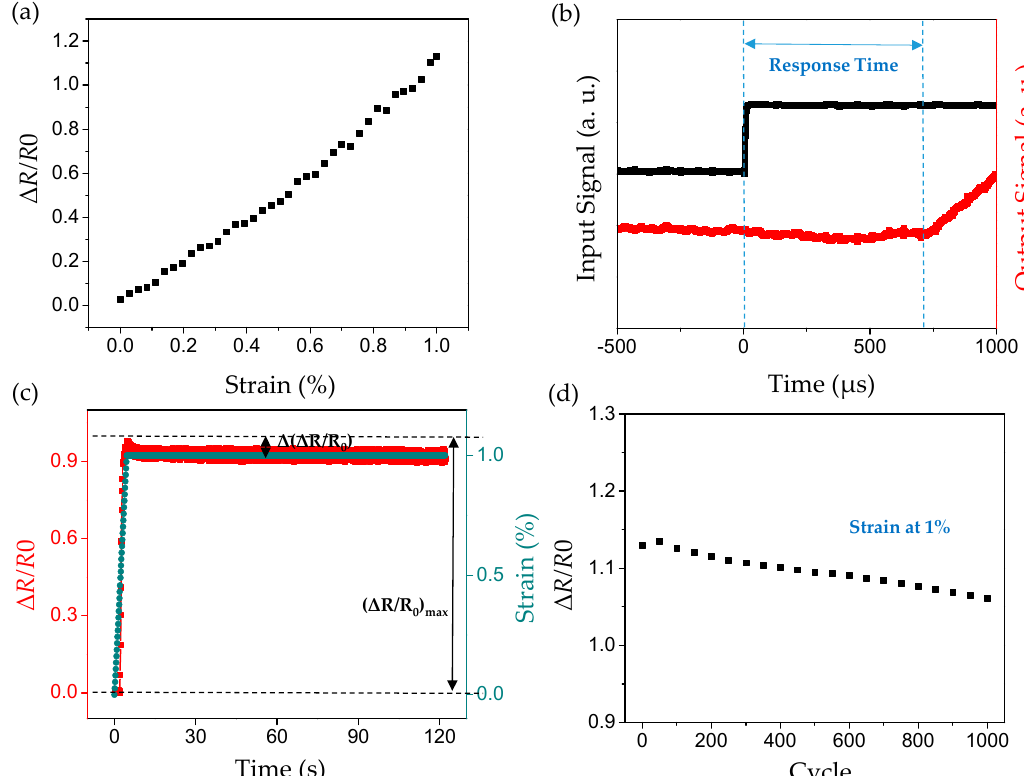
Figure 3. The flexible strain sensor shows high performances. ( a ) Resistance changes of the strain sensor under 0–1% strain at the 1000th cycle of loading/unloading test; ( b ) the response time is within the range of 400 to 700 μ s under the impact acceleration of 500 g; ( c ) the measurement of the creep characteristic, blue curve represents the strain measurement curve of sensor with time and the red one is the actual Δ R/R0 measurement curve; ( d ) Δ R/R0 value of the sensor at strain 1% under 1000 cyclic measurement of 0–1% strain, sampling every 50 cycles.